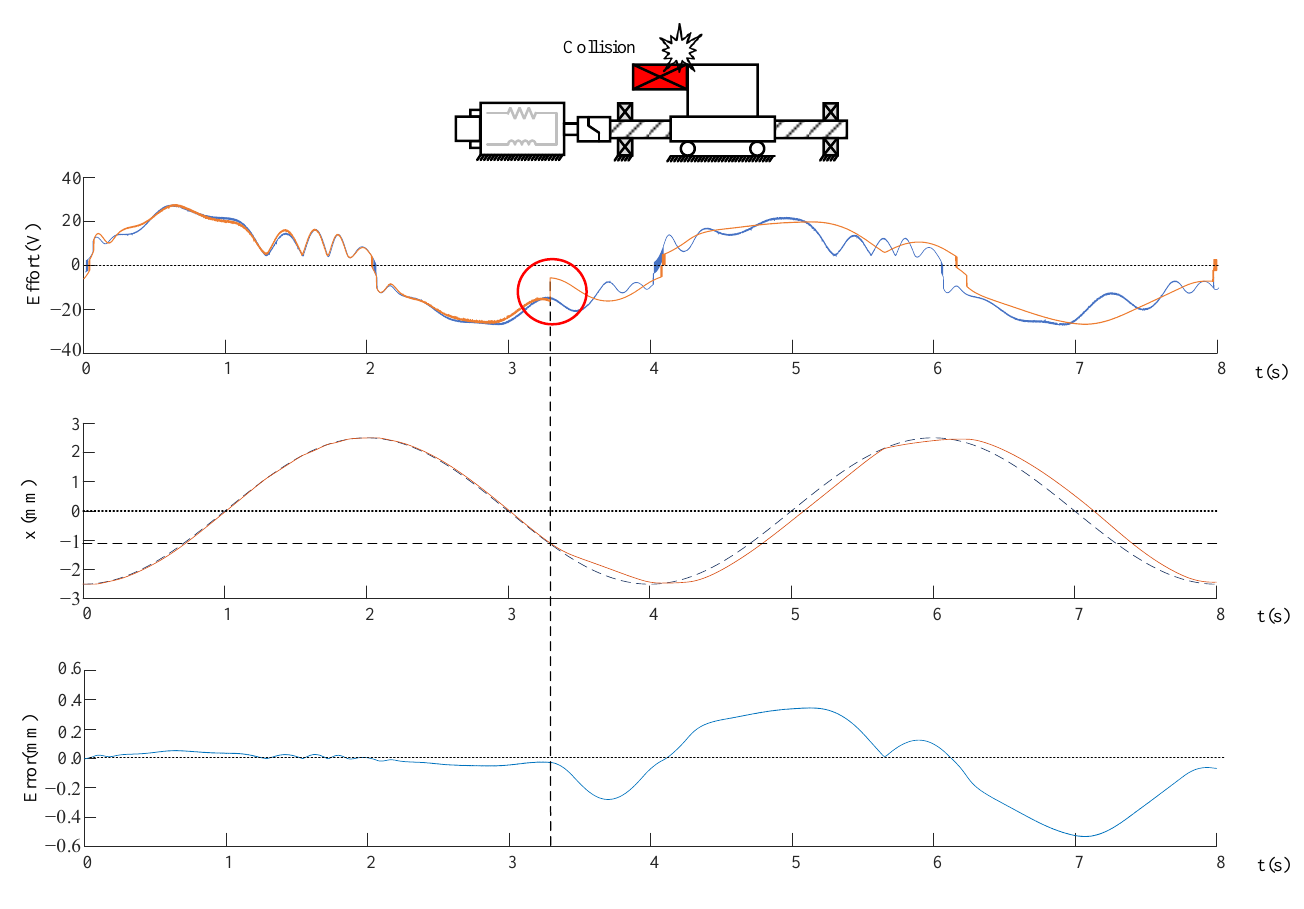
Figure 8. Anomaly detection and controller’s adaptability. Table 3. Observable performance of the proposed